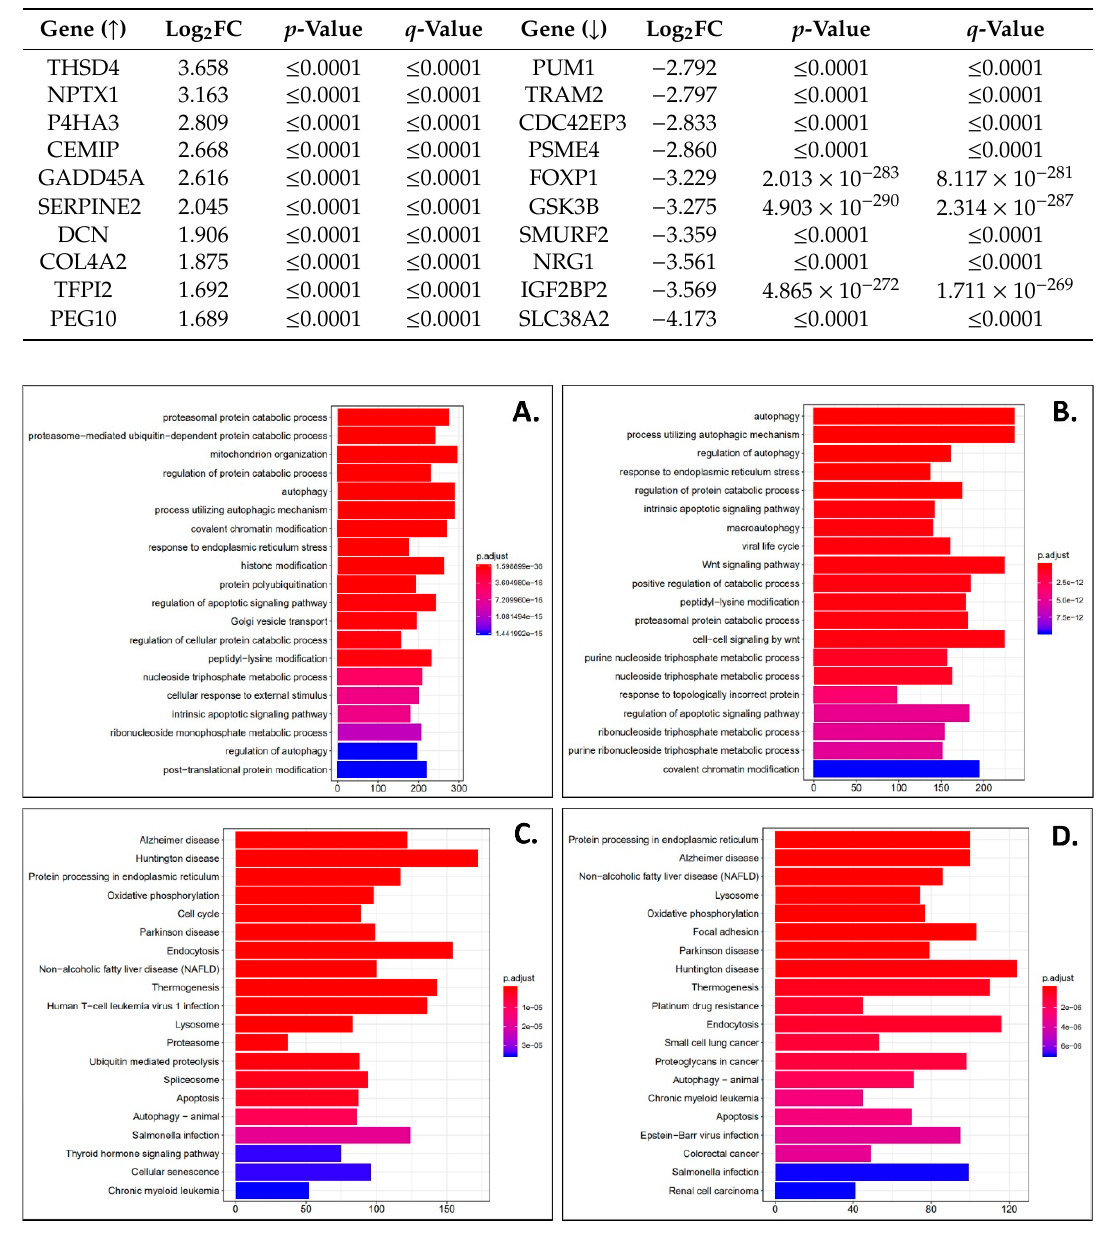
Table 6. Comparative analysis of gene regulation between phenanthriplatin and cisplatin treatments in A549 and IMR90 cells. Top 10 up-and downregulated DEGs for IMR90 phenanthriplatin versus IMR90 cisplatin. DEG data analysis: ( p ≤ 0.05; q ≤ 0.05; log 2 FC ≥ 0; FPKM ≥ 1 in ≥ 3 samples; average FPKM ≥ 1 minimum count: 10).